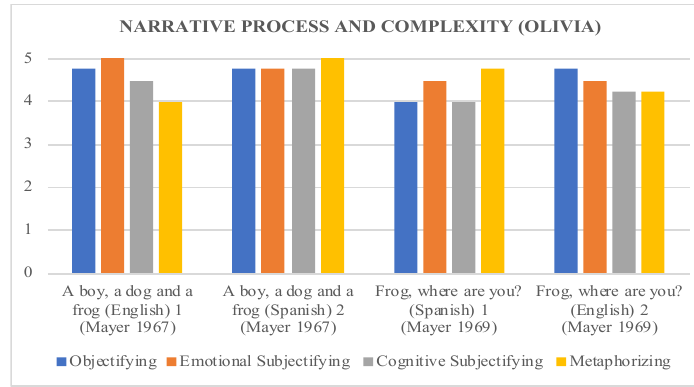
Figure 6. Olivia’s scores for the narrative process and complexity dimension.